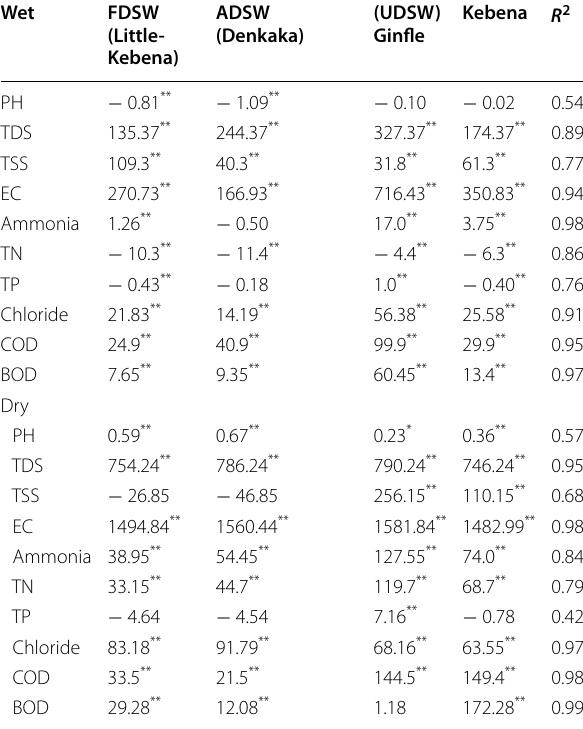
Table 4 Results regression